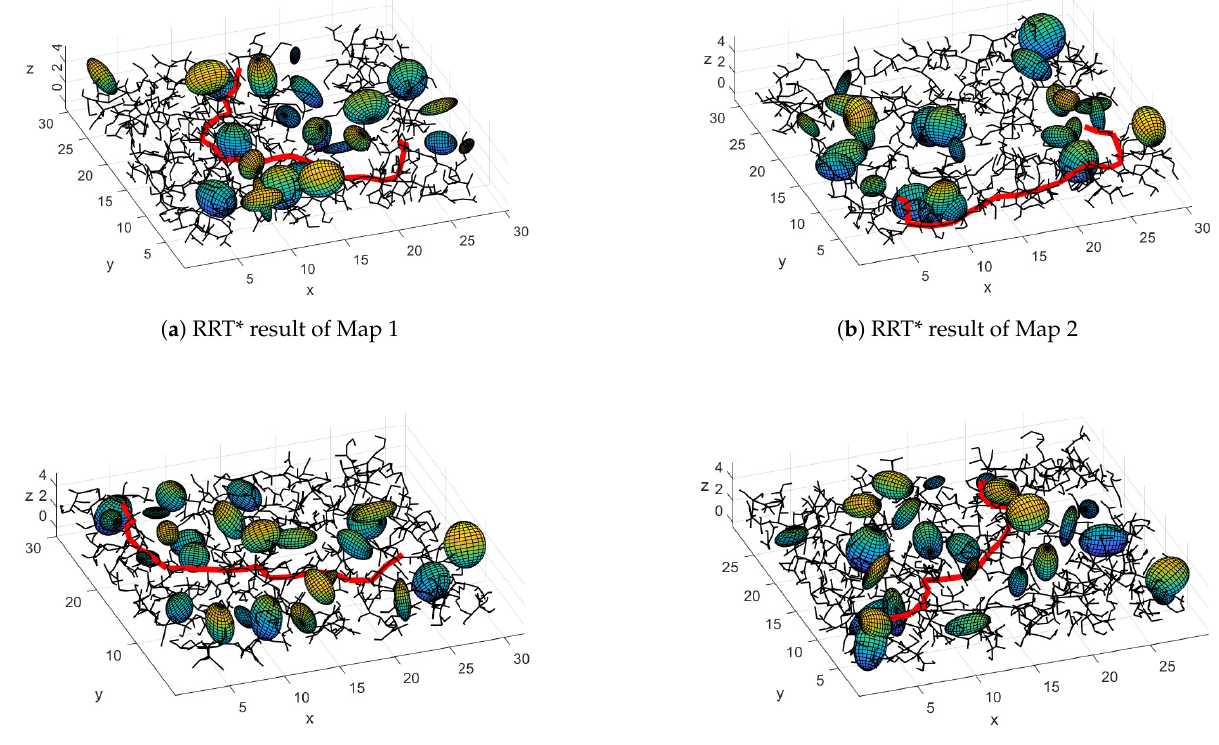
Figure 13. RRT* results of the maps 1 to 4. We show the constructed tree in black and the best found path in red. All the evolutionary algorithms used the same fitness function presented in (7). All